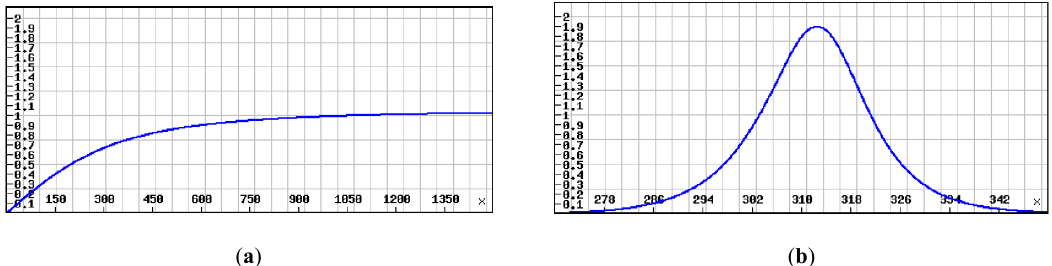
Figure 1. ( a ) Isoprene emission dependence on photosynthetic active radiation; x-Axis = photosynthetic active radiation in µ mol m − 2 s − 1 , y-Axis = normalized isoprene emission for γ P ; and ( b ) isoprene emission dependence on leaf temperature; x-Axis = leaf temperature in Kelvin, y-Axis = normalized isoprene emission for γ T .